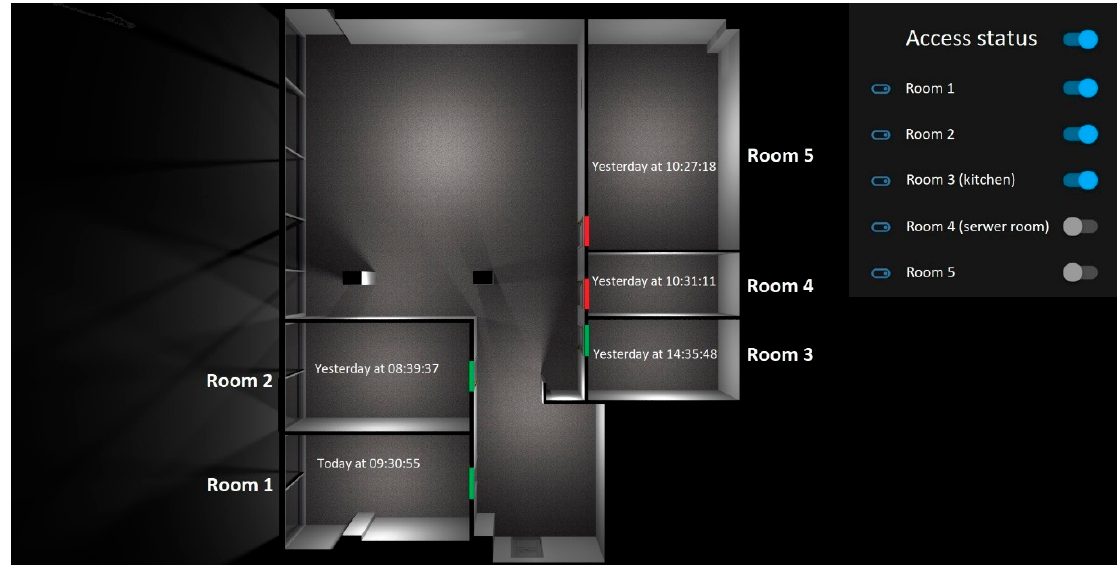
Figure 15. Graphic panel of the access control system to individual rooms of an intelligent building designed by CBRTI Sp. z o.o. Research and Development Center.